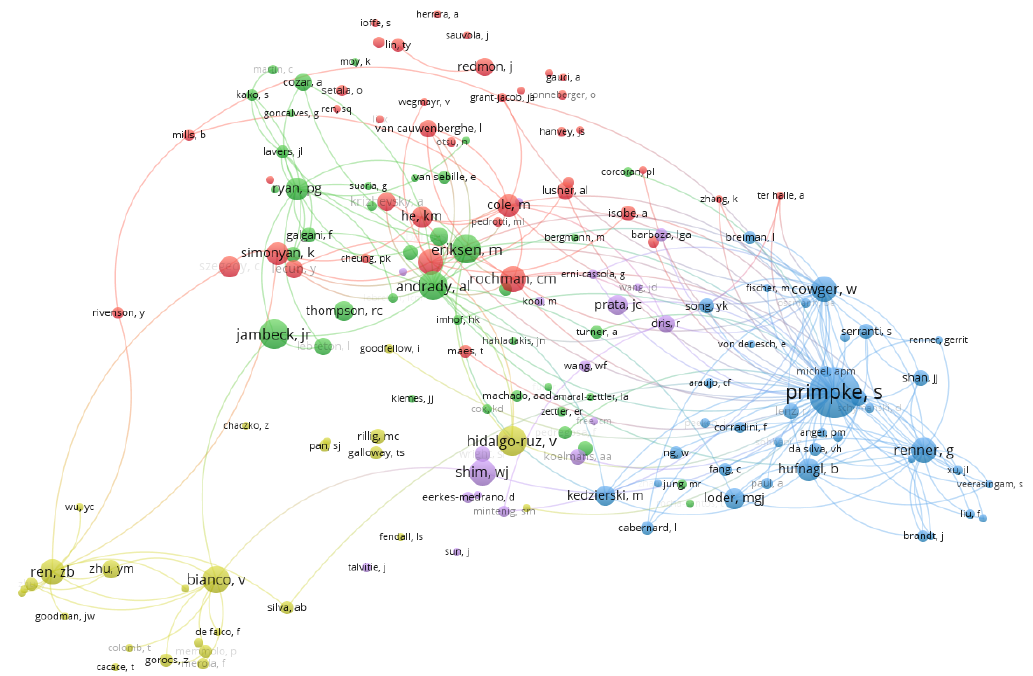
Figure 16. Co-cited network of authors (Threshold = 4) (visualized with VOSviewer).